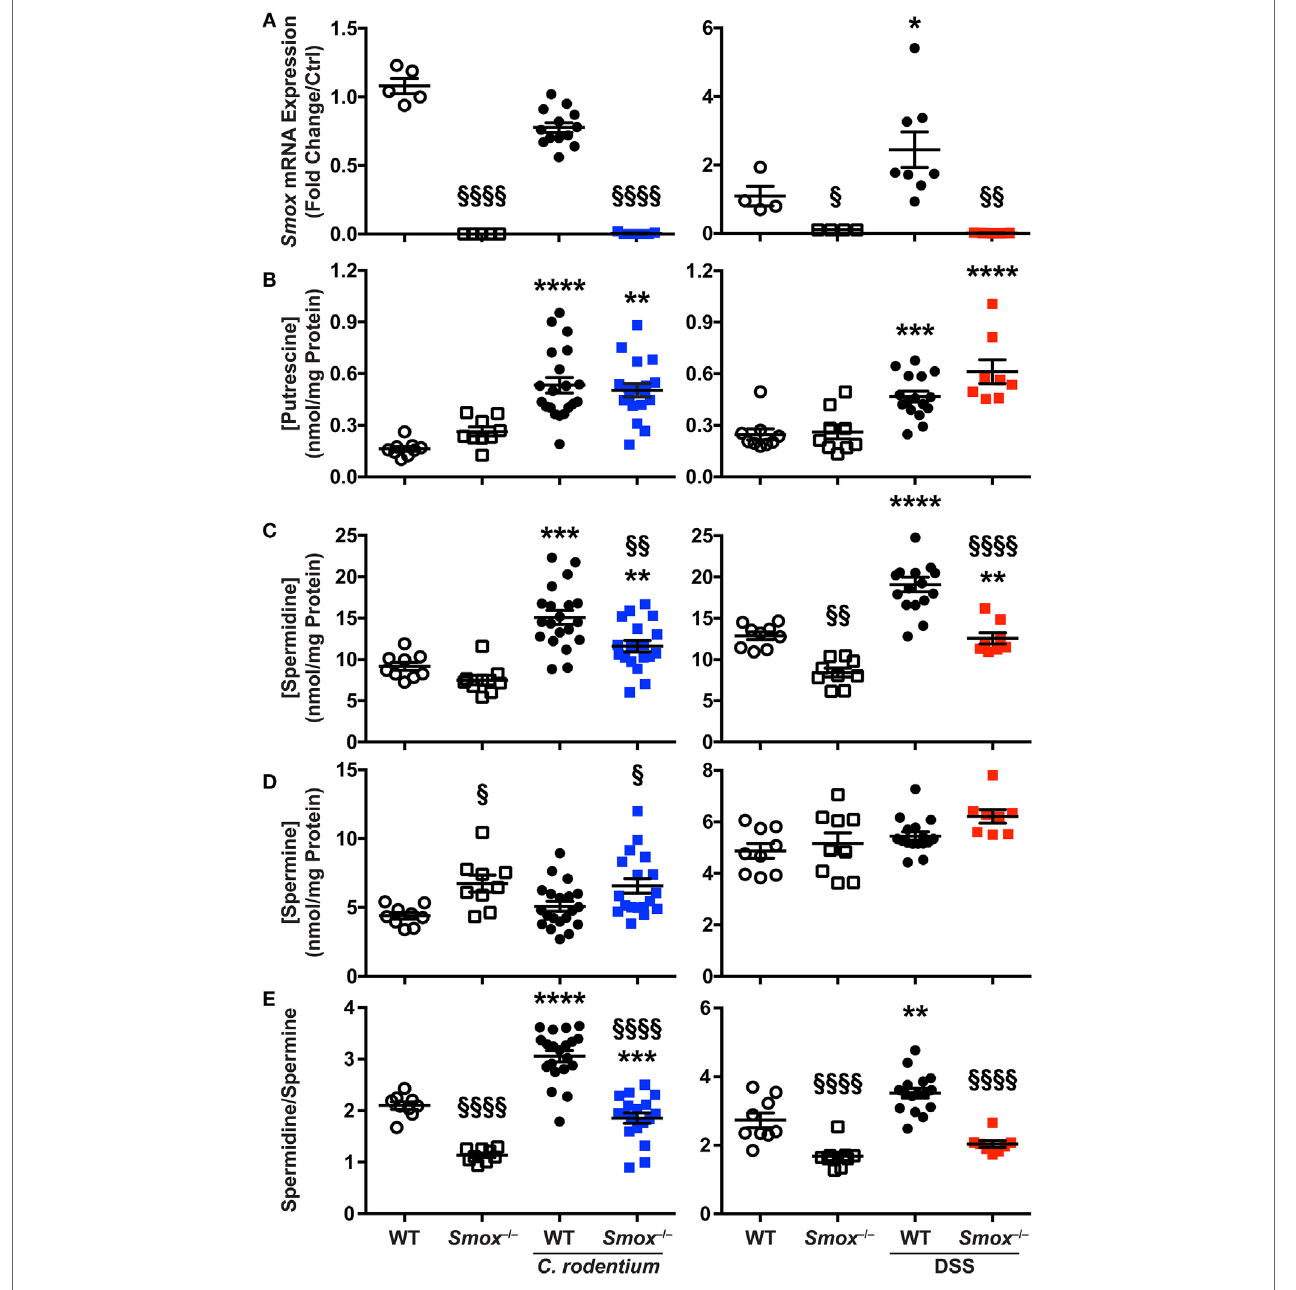
FigUre 4 | Smox expression and polyamine profiles during murine colitis. (a) Smox mRNA expression in the colon. (B–D) The concentration of putrescine (B) , spermidine (c) , and spermine (D) was determined by LC/MS in the colonic tissues. (e) The spermidine/spermine ratio was calculated using the values depicted in panels (c,D) . * P < 0.05, *** P < 0.001, and **** P < 0.0001 compared with naïve mice; § P < 0.05, §§ P < 0.01, and §§§§ P < 0.0001 compared with wild­type (WT) mice infected with Citrobacter rodentium infection or treated with dextran sulfate sodium